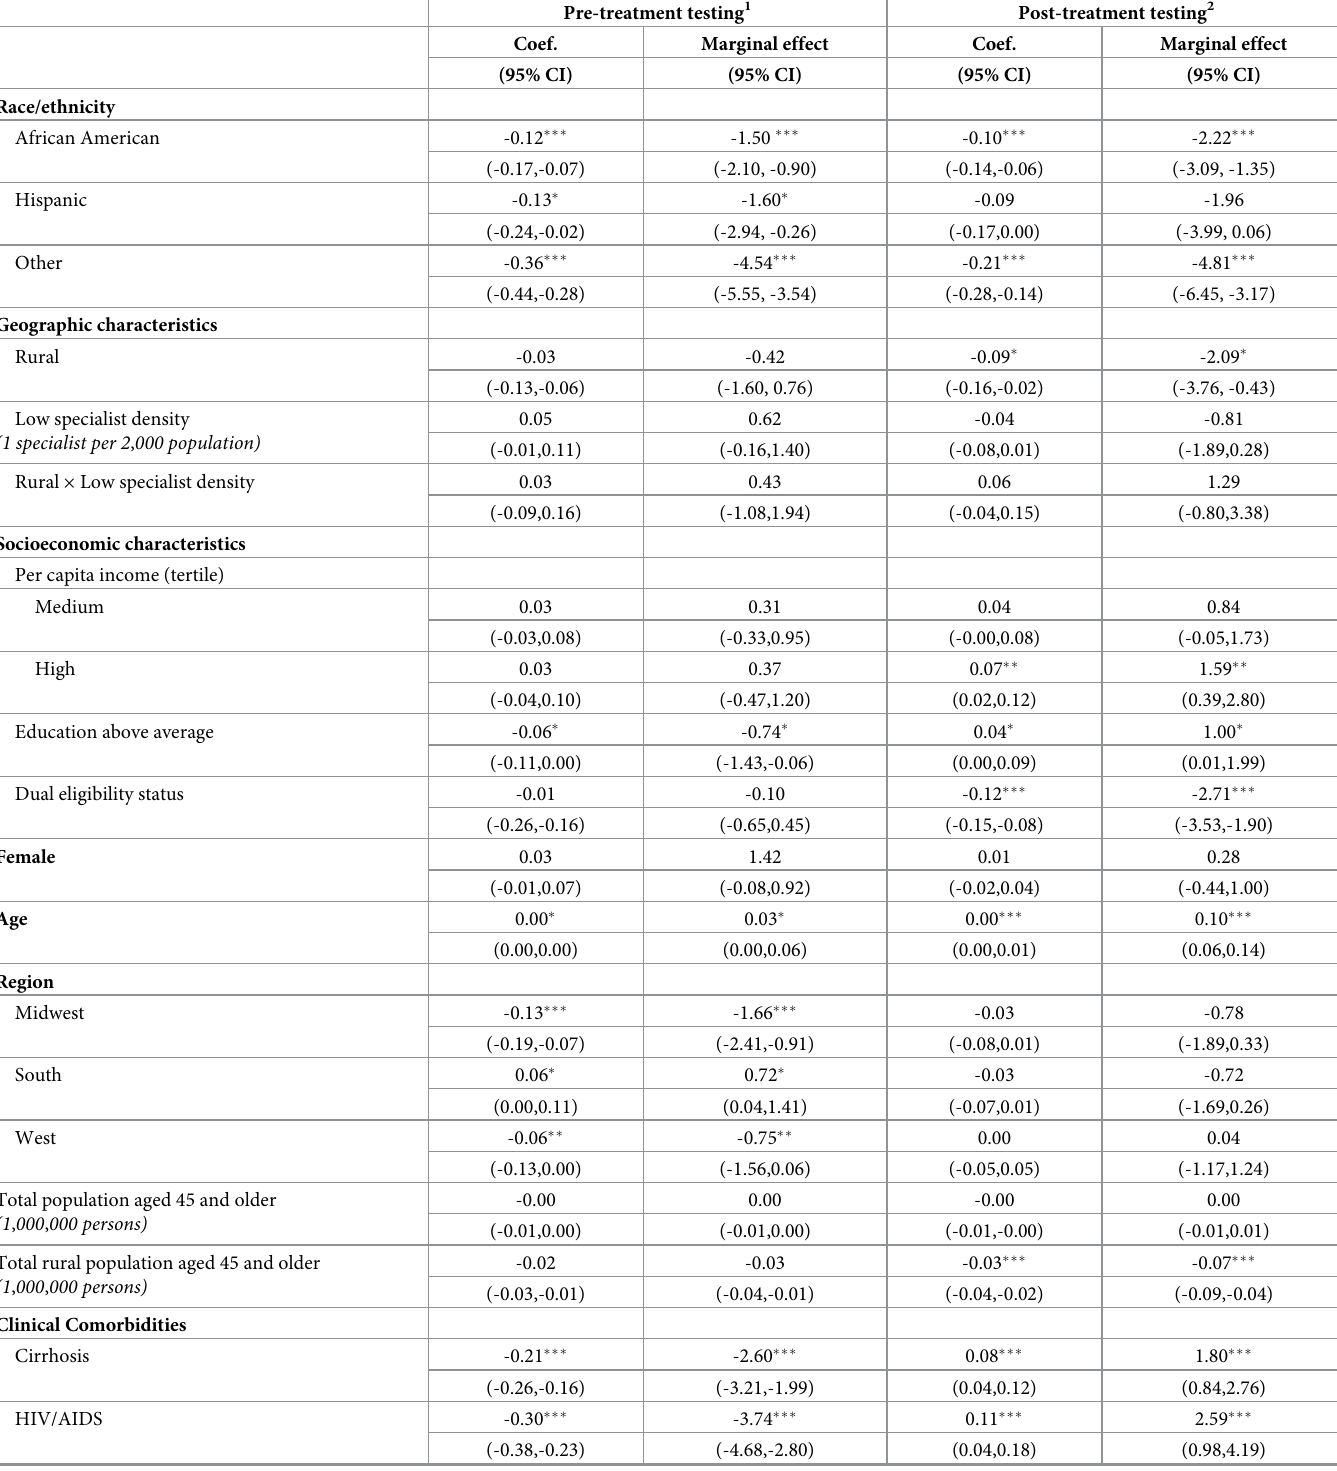
Table 2. Estimated coefficients of bivariate probit model and marginal effects (N =